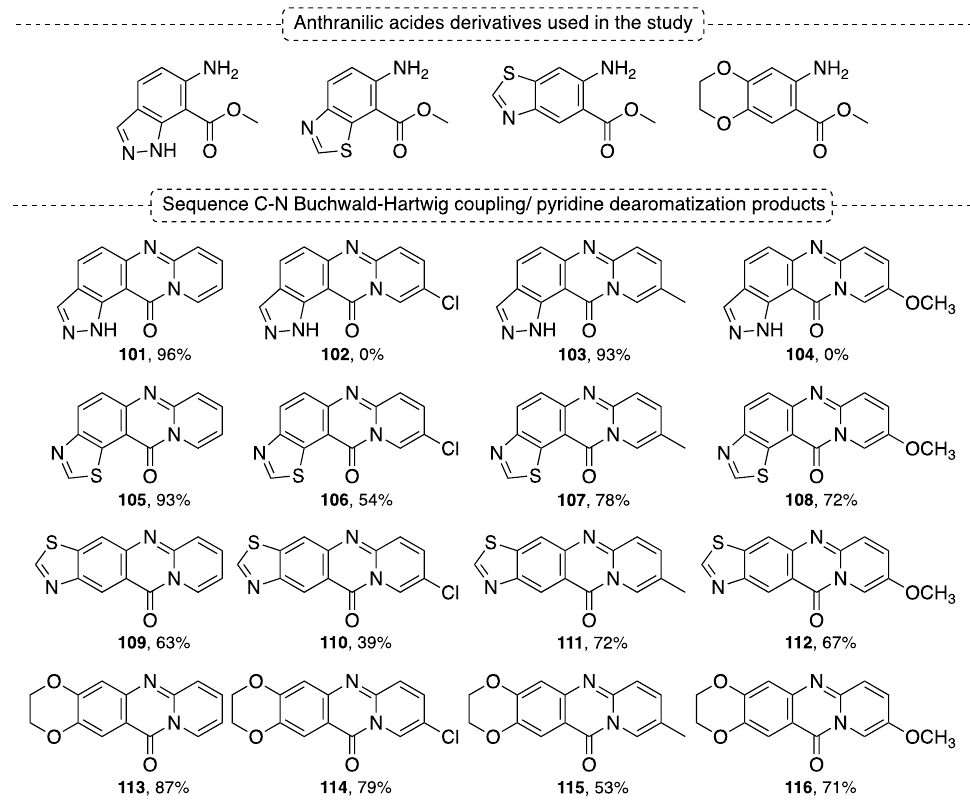
Figure 12. Pyridoquinazolinone derivatives in eucalyptol [169].